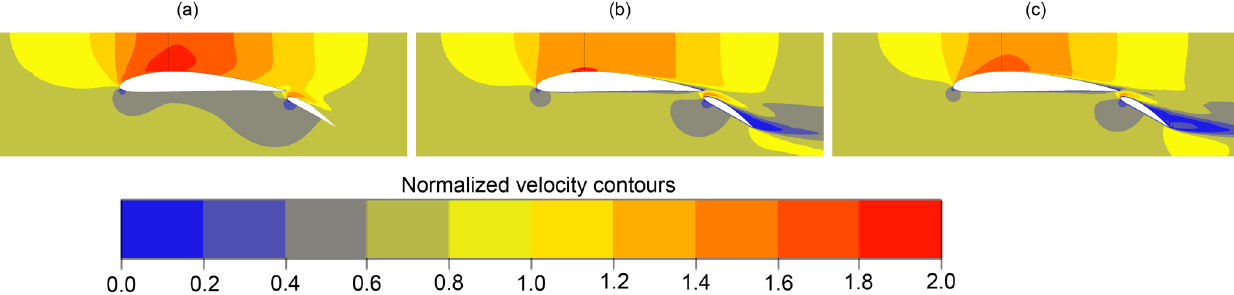
Figure 4. Velocity contours colored with normalized free-stream velocity obtained using the (a) panel method, (b) RANS method and (c) URANS method for Model C (ii) + flap.